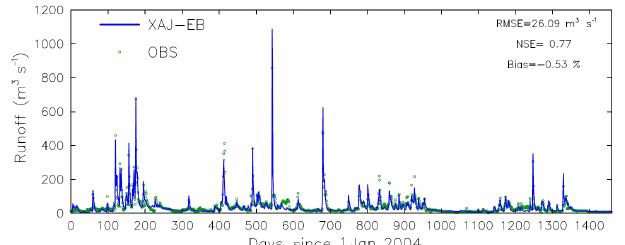
Figure 6. Comparison between observed and XAJ-EB-modeled daily runoff for tue ChongYang hydrological site for period between 1 January 2004–31 December 2007. Also shown the evaluation met- rics including RMSE, NSE, and bias.